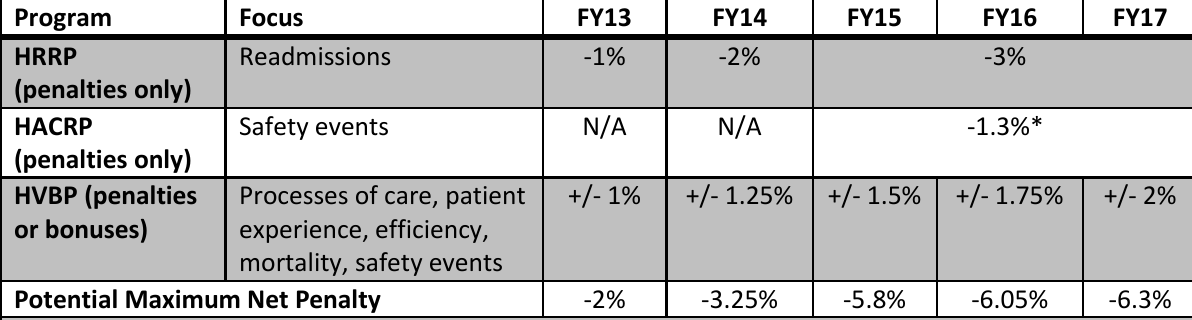
Table S2.1 Hospital Payments at Risk in the 3 Hospital Pay-for-Performance